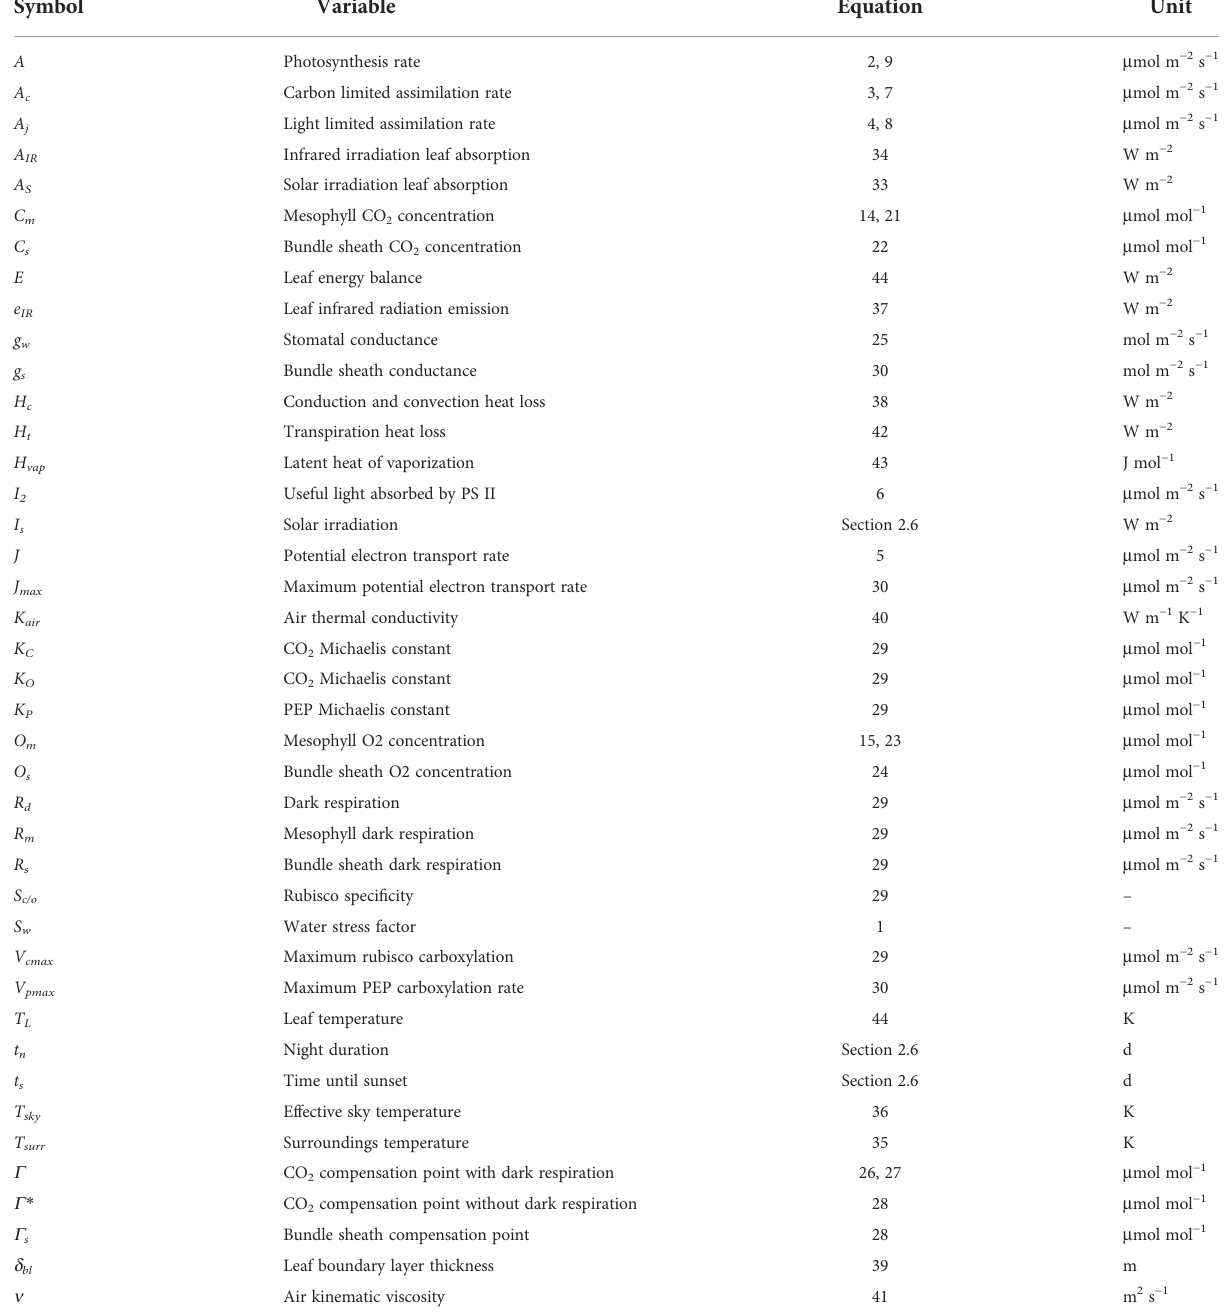
TABLE 1 Derived and temperature-dependent variables related to newly added